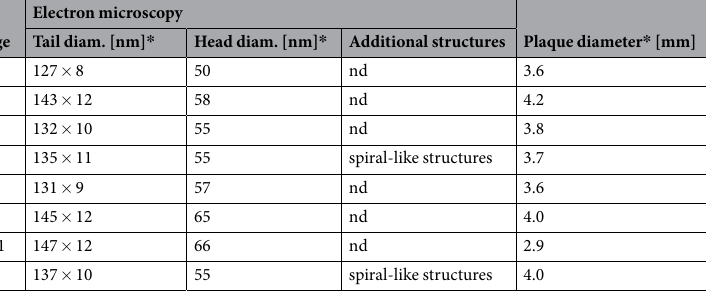
Table 3. Characteristic morphological features of the studied phages. The size of phage particles was calculated using measure IT 5.0 (Olympus Soft Imaging Solutions GmbH) software. * Mean from n = 5 phages. nd – none detected.